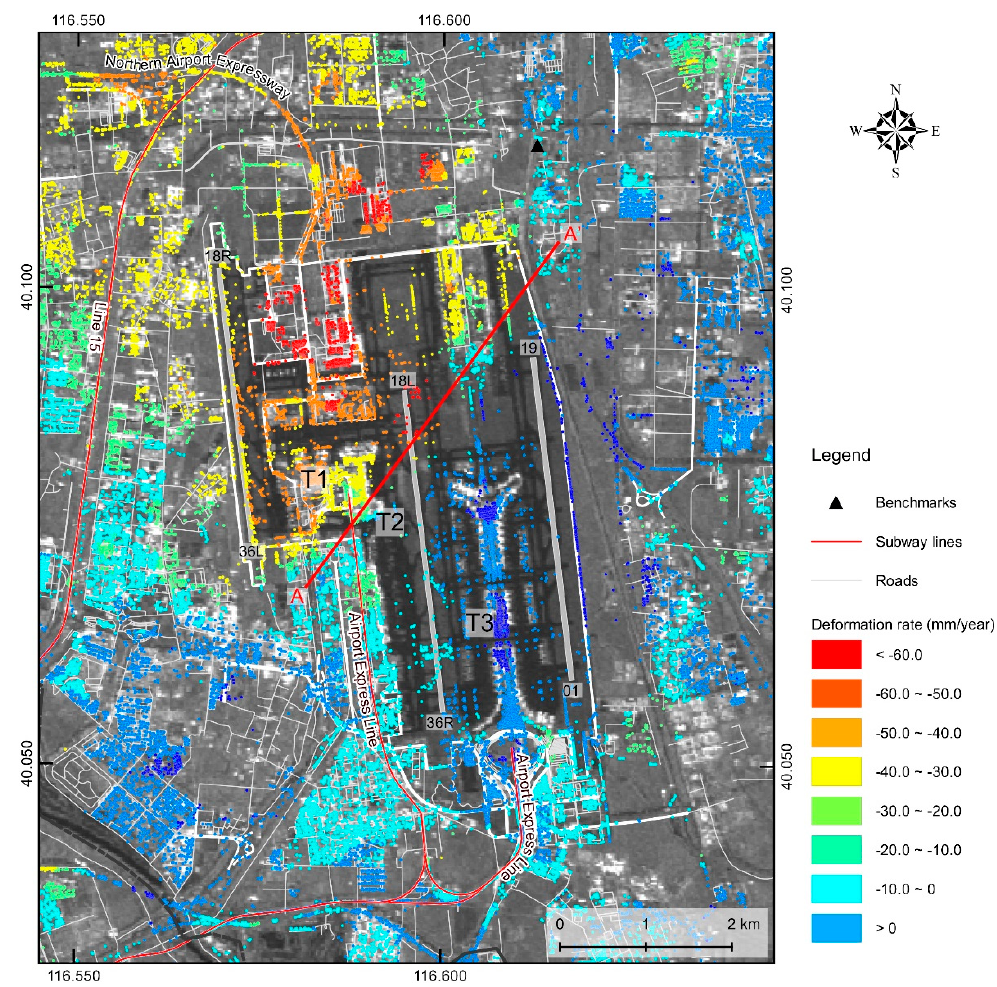
Figure 5. Vertical deformation rate map superimposed on SAR reflectivity in the BCIA area. A − A’ is an imaginative boundary that divide the airport area into two subregions with distinct subsidence characteristics. The red lines represent subway lines.